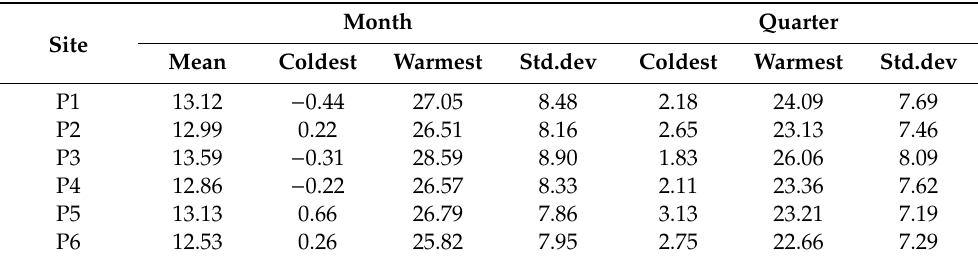
Table 1. Statistics of the sea surface temperature (SST) time series at P1 to P6 from Januaray 1982 to December 2019 (the unit is ◦ C).